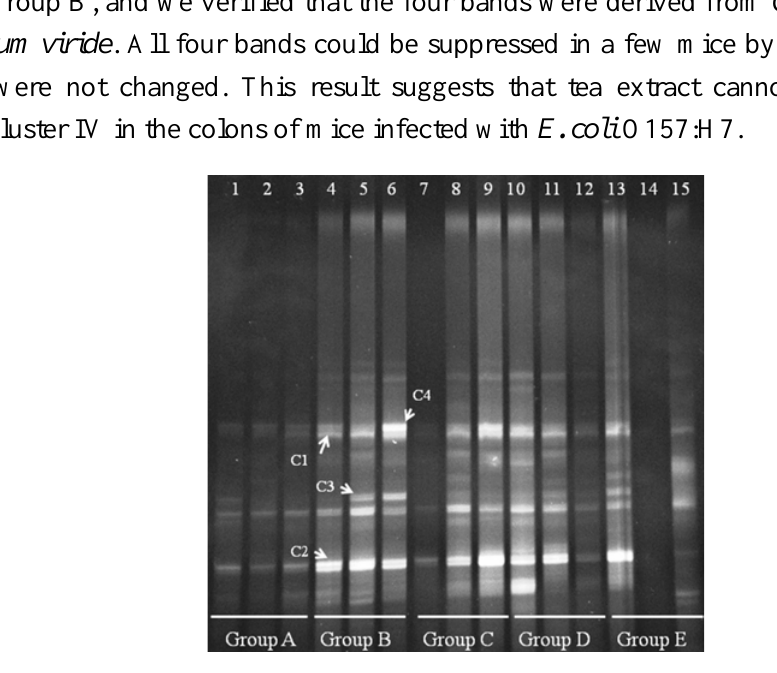
Figure 6. Denaturing gradient gel electrophoresis (DGGE) for Clostridium cluster IV obtained from the mouse distal colonic microbiota. Lanes 1–3 (Group A) represent normal controls. Lanes 4–6 (Group B) represent infection models. Lanes 7–9 (Group C) represent infected mice treated with low-dose FTBE. Lanes 10–12 (Group D) represent infected mice treated with middle-dose FBTE, and lanes 13–15 (Group E) represent infected mice treated with high-dose FBTE. Representative bands (indicated by C1–C4) were excised for cloning and